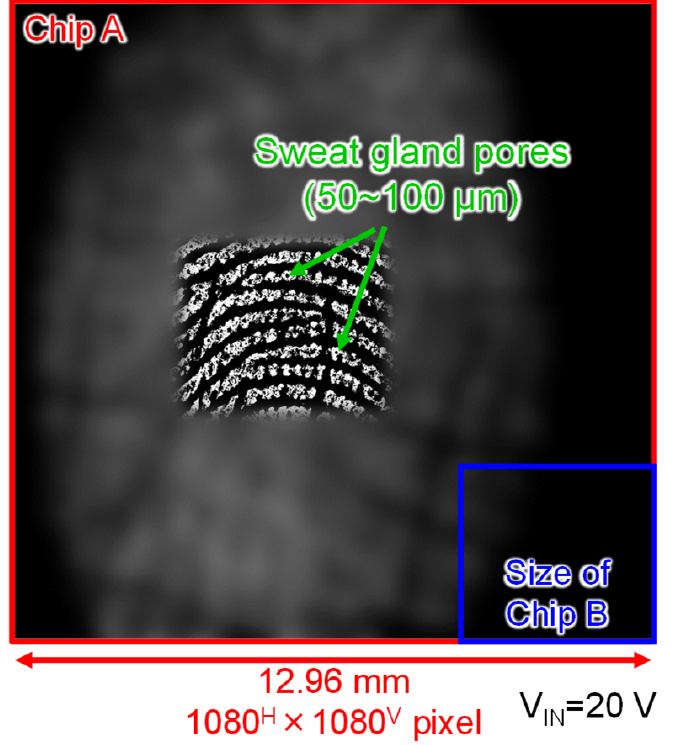
Figure 14. Captured image of a fingerprint by the large format Chip A (blurred for privacy).